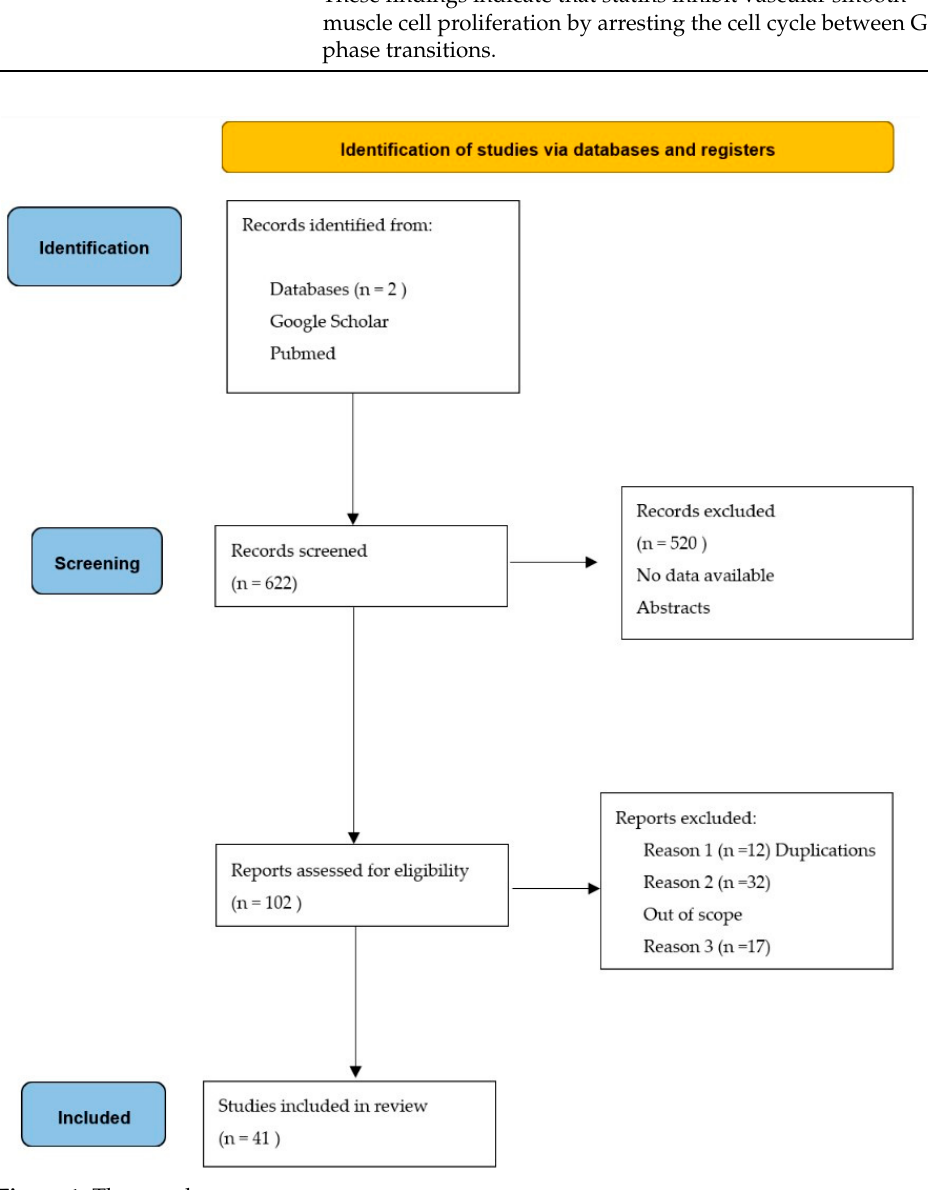
Figure 1. The search